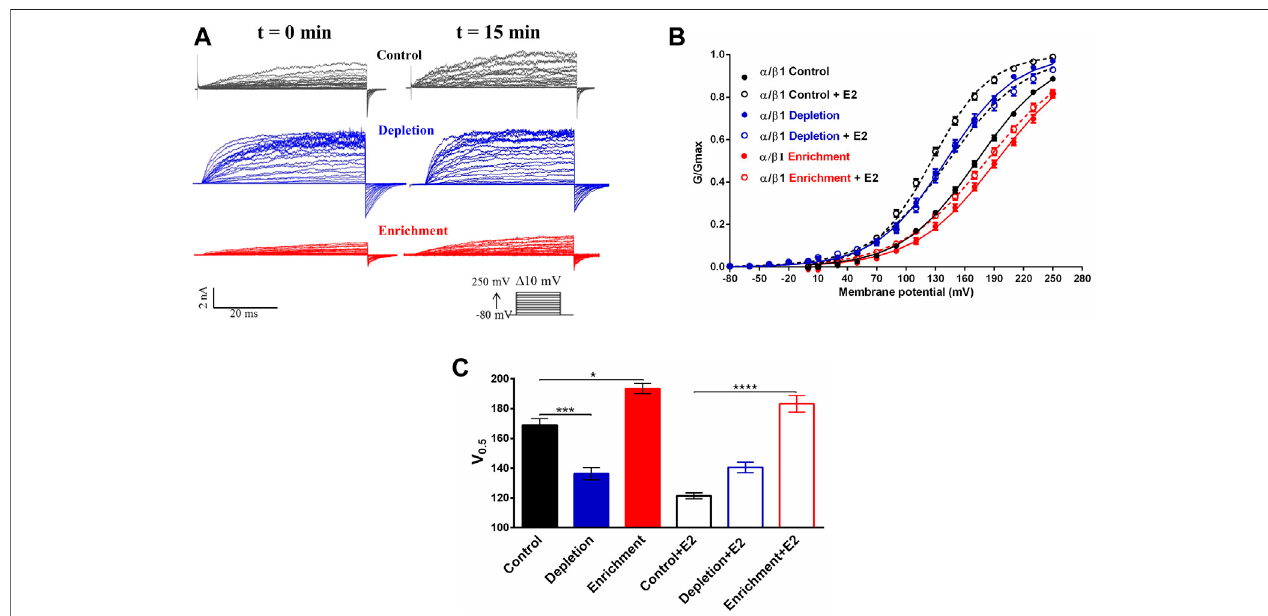
FIGURE 4 | Effect of the membrane cholesterol content on the modulation of the BK channel by E2. (A) Representative recordings of BK α / β 1 channel current before and after 10 μ M E2. Black traces: control without treatment; blue traces: depletion with M β CD; red traces: enrichment with M β CD-CLR. (B) G/V relationships for α / β 1channelscomplexesbefore( fi lledcircles)andafterexpositionto10 μ ME2(emptycircles).LinesrepresentthebestBoltzmann fi t.Control:blacksymbols;depletion: blue symbols; enrichment: red symbols. (C) Quanti fi cation of V 0.5 obtained from the G-V curves from α / β 1 channels. Black traces: control without treatment; blue traces: depletion with M β CD; red traces: enrichment with M β CD-CLR, with or without E2 as indicated (mean ± SEM). Differences between channels and experimental conditions were analyzed using a t -test. Half activation voltages (V 0.5 ) were: Control conditions : 169 ± 4 mV (black fi lled bar), Control conditions + E2 : 121 ± 2 mV (black emptybar);cholesteroldepletion:137 ± 4 mV(blue fi lledbar),cholesteroldepletion+E2:140 ± 4 mV(blueemptybar);cholesterolenrichment:194 ± 3 mV(red fi lledbar), cholesterol enrichment + E2: 187 ± 5 mV (red empty bar). **** p < 0.0001, *** p < 0.001, * p < 0.05. n (cid:2)